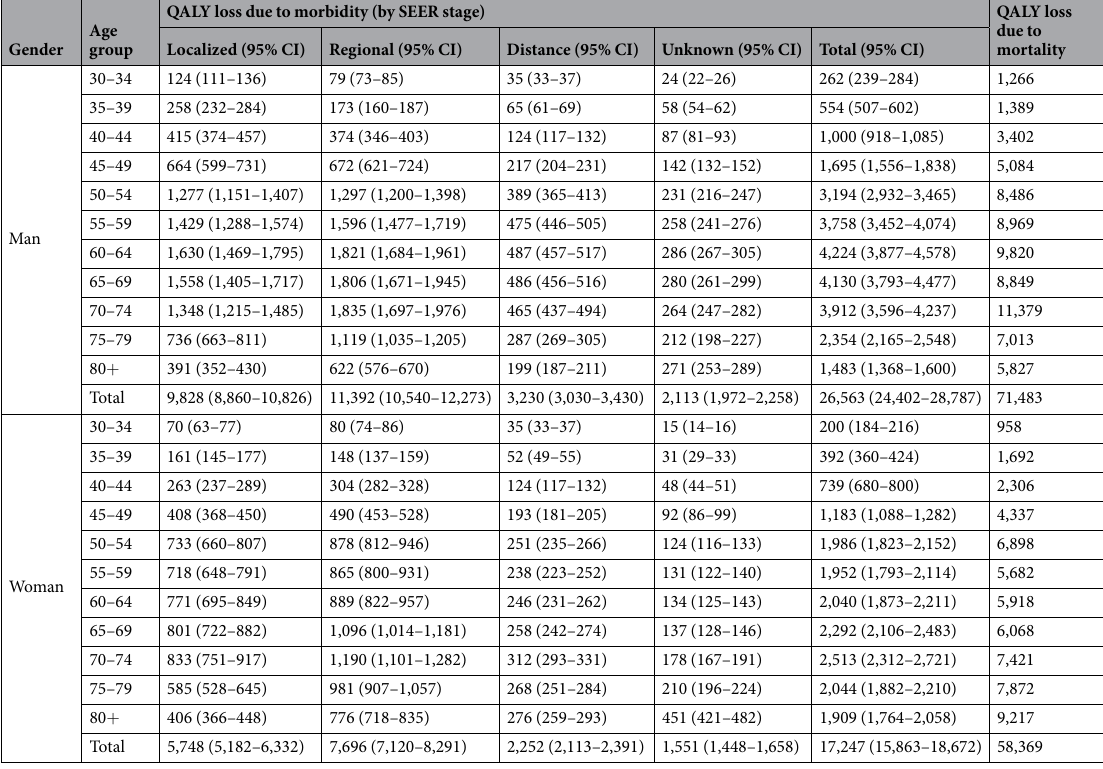
Table 3. QALY loss due to colorectal cancer by gender and age group in Korea in 2013. Quality-adjusted life year (QALY); Confidence interval